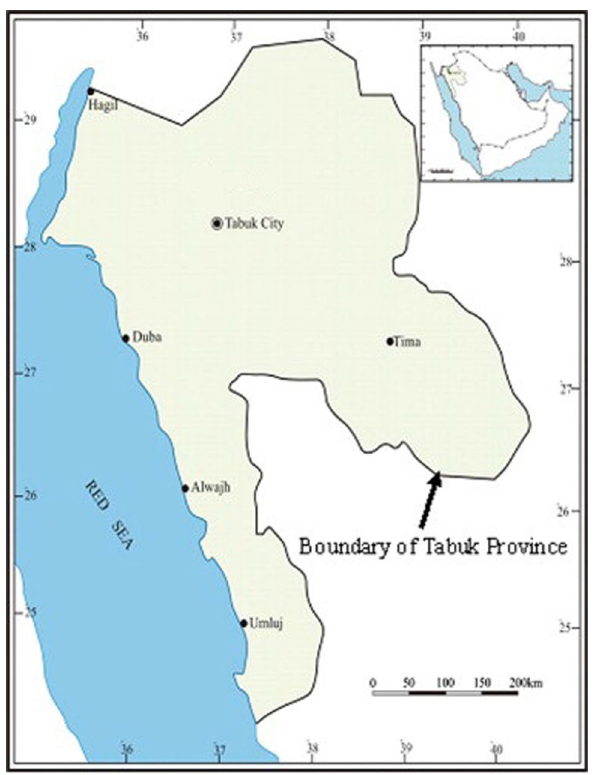
Fig. 1 Study area (source: Al-Harbi 2010)